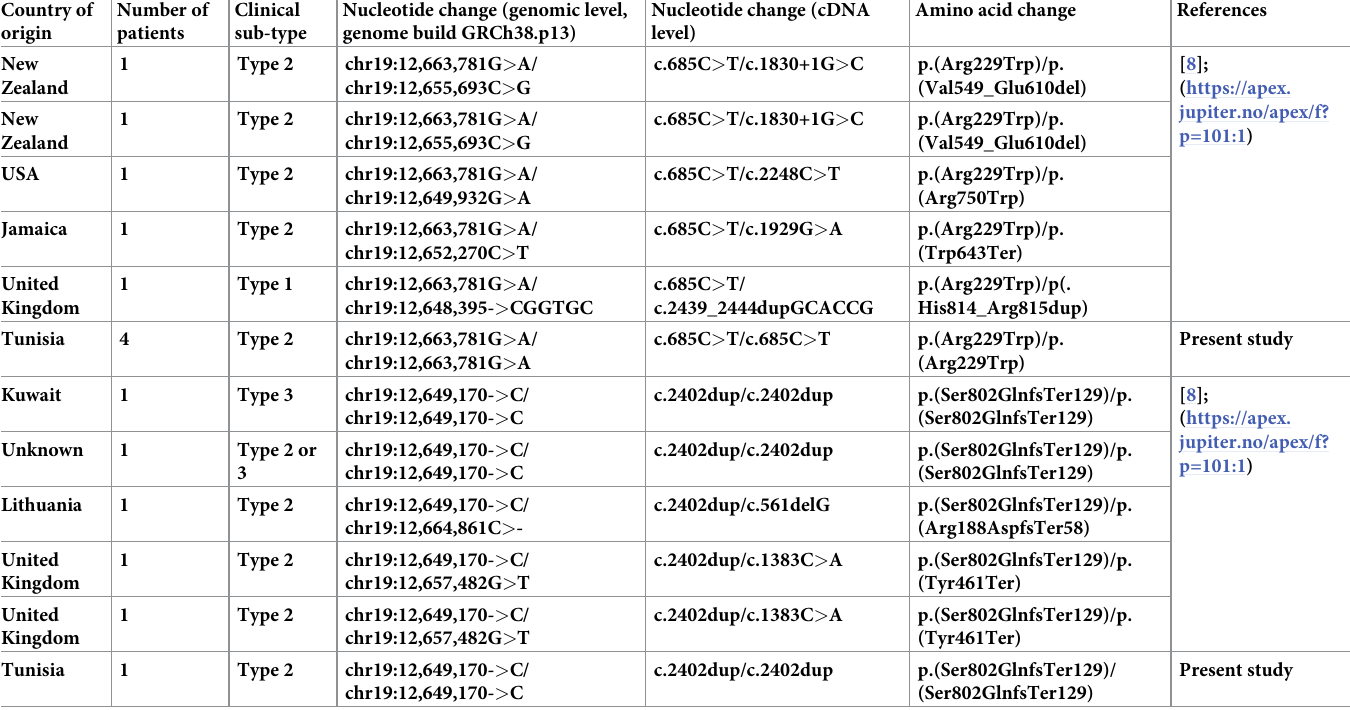
Table 2. Mutational, phenotypic, and geographical data of patients carrying the MAN2B1 (NM_000528.4) gene disease-causing variants identified in TNDF182 and TNDF617 families.